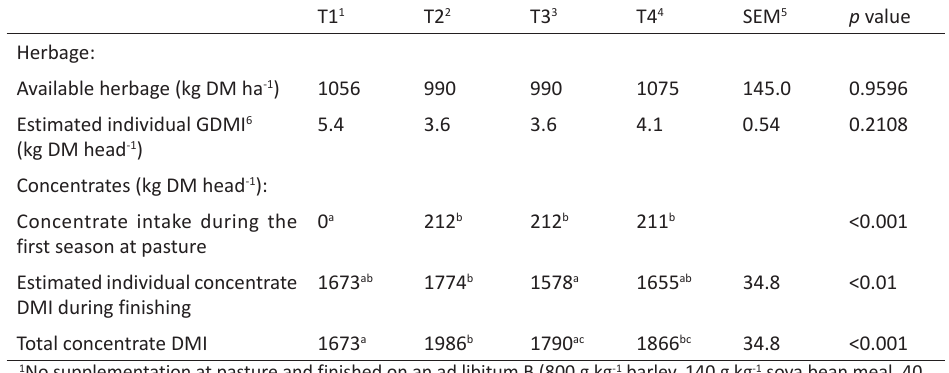
Table 2. Effects of finishing regime on pre-and post-grazing sward heights and estimated individual dry matter intake (DMI) on Holstein-Friesian bulls slaughtered at 15 months of age T1 1